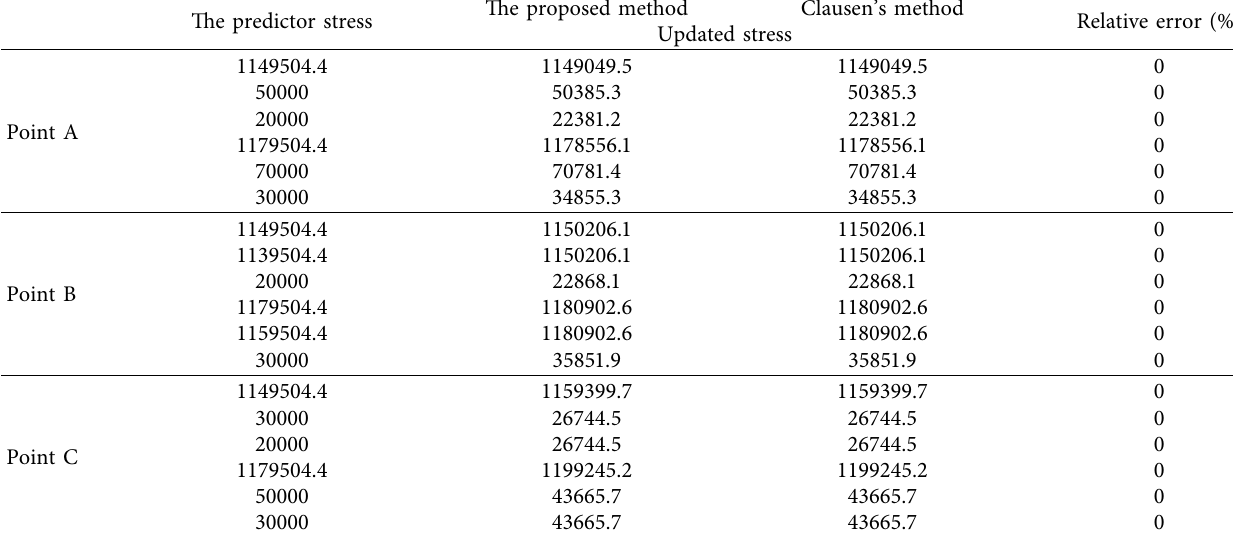
Table 1: The values of the updated stress obtained by the proposed method and Clausen’s method and the relative errors (associated case). The proposed The predictor stress